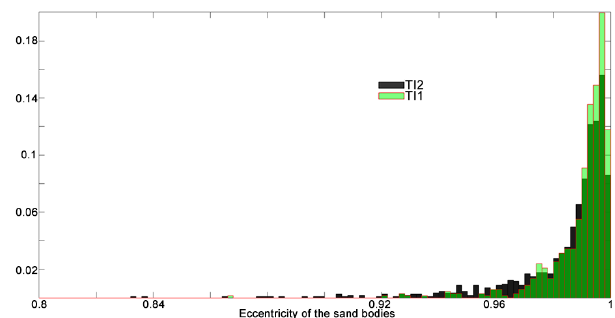
Figure 13. Probability of the eccentricity of the sand bodies (with a size larger than 1000) for the unconditioned realizations obtained by using the two TIs in Fig. 10.